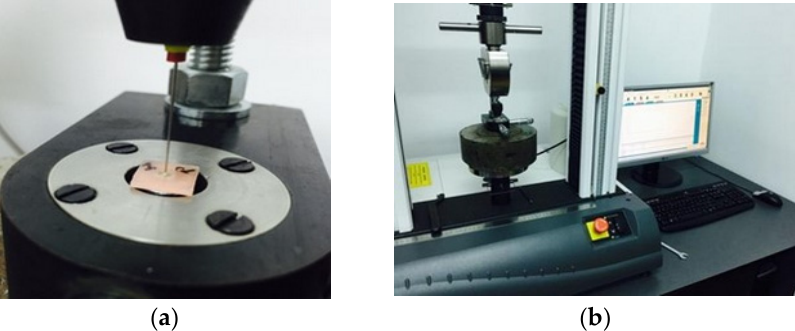
Figure 3. Push-out test performed in a coronal direction by the universal testing machine ( a ). The force required for dislodgement was recorded ( b ).